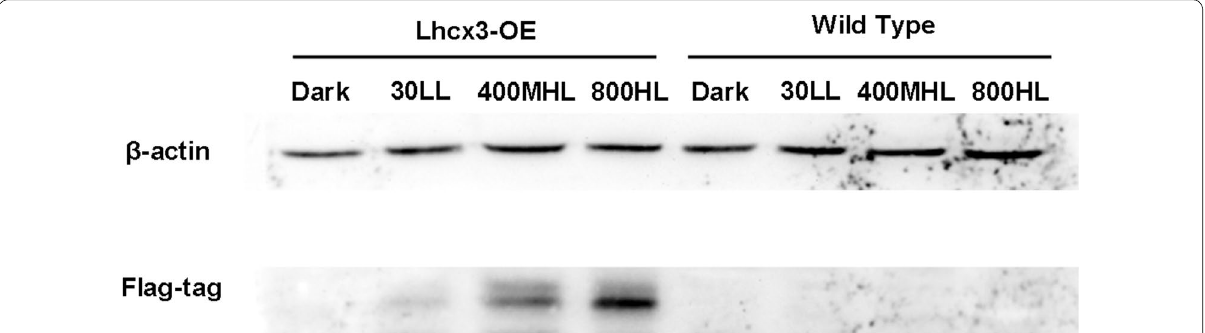
Fig. 5 Western blot analysis of FLAG‑tag in WT and Lhcx3 ‑overexpressed lines (Lhcx3‑OE) under different light treatments. β‑actin was used as an internal control. LL